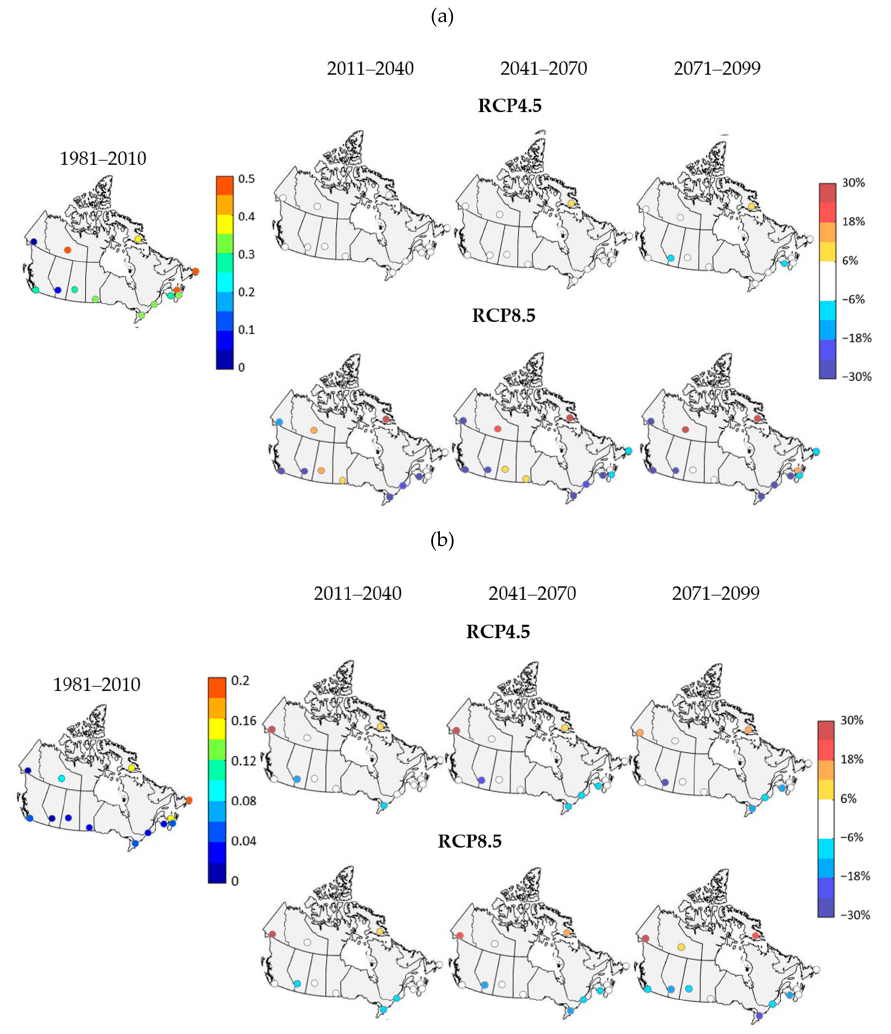
Figure 10. Same as Figure 9, but for tailwind larger than ( a ) 5 knots and ( b ) 10 knots.